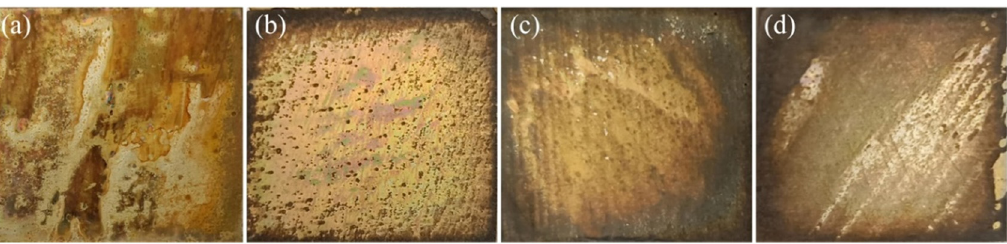
Figure 10: Macroscopic morphology of electrochemical corrosion surface of the samples in di ff erent Cl − concentration media: ( a ) 3.5% NaCl; (